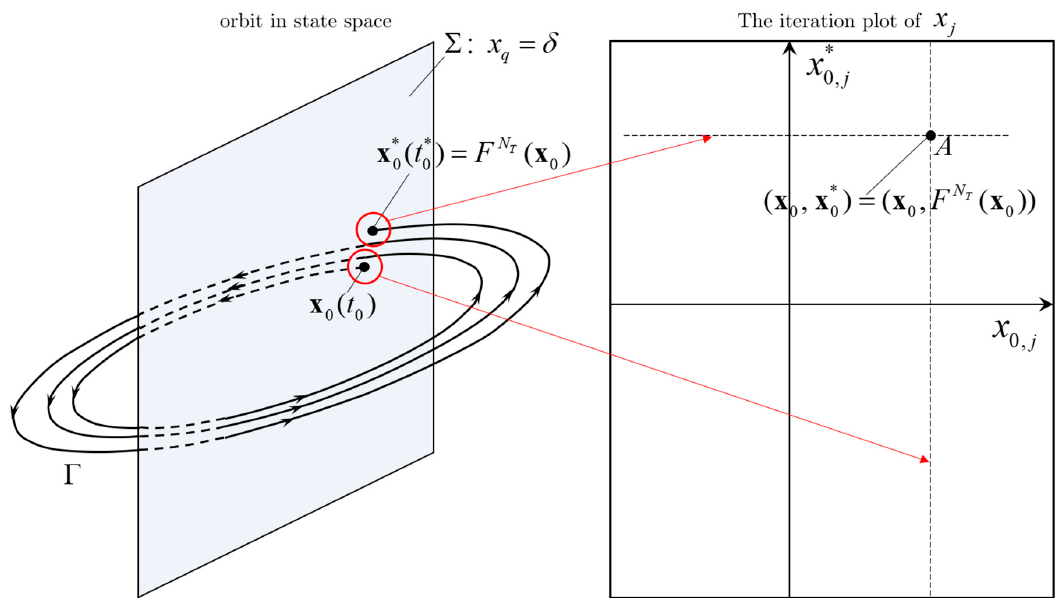
Figure 6. Illustration of an iteration plot, in which point A represents how a state behaves when the system evolves from the upper freeplay boundary and returns to that boundary after crossing it several times.